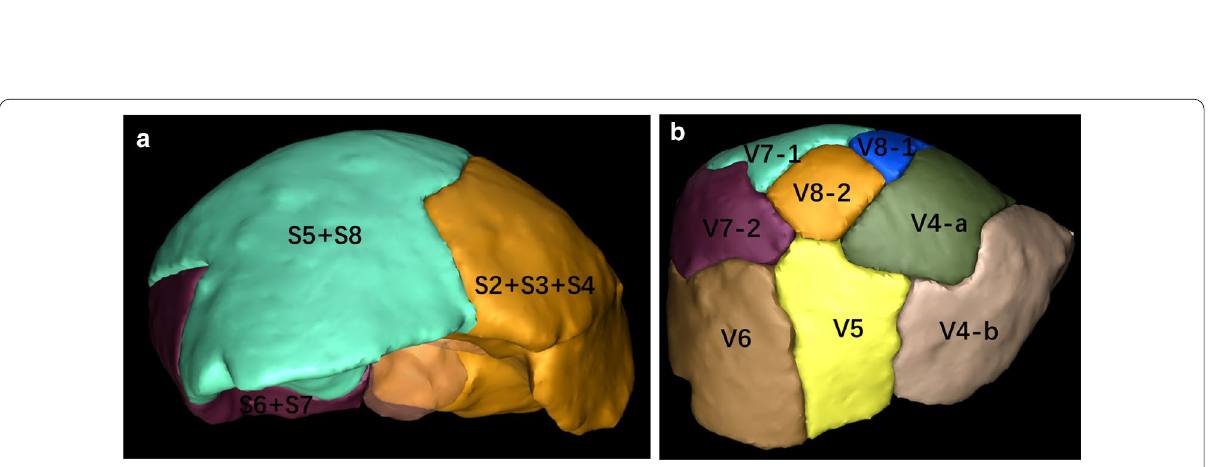
Fig. 9 a Shows the area dominated by portal vein branch. The area dominated by portal vein branch: S2 (47.0%), S6 S7: 146 mL (14.9%). b Shows the area dominated by hepatic vein branch. The area dominated by hepatic vein branch: V4-a: 76 mL + (7.9%), V4-b: 214 mL (22.4%), V5: 154 mL (16.1%), V8-1: 30 mL (3.1%), V8-2: 45 mL (4.7%), V6: 168 mL (17.6%), V7-1: 60 mL (6.3%), V7-2: 150 mL